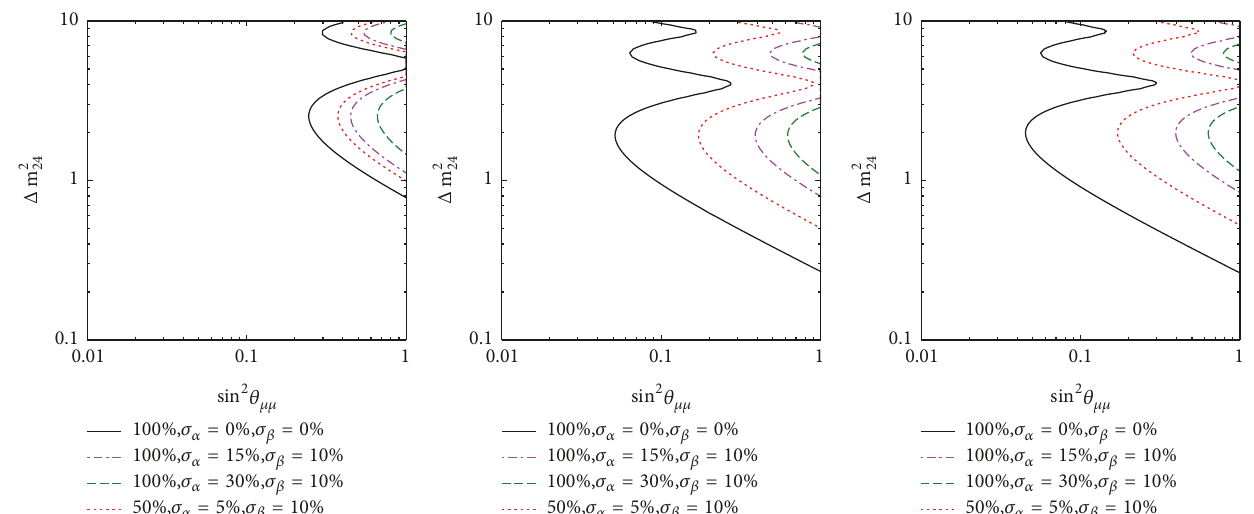
Figure 6: Expected sensitivity for a muon neutrino oscillation into a sterile neutrino state, for the different detectors under consideration: Germanium (left), Argon (middle), and NaI (right), respectively. Again, the different curves are for the ideal case of 𝜎 𝛼 = 0 % with 100 % efficiency and a background error of 𝜎 𝛽 = 0 % (solid), for 𝜎 𝛼 = 5 % with 50 % efficiency and a background error of 𝜎 𝛽 = 10 % (dotted), for 𝜎 = 15 % with 100 % efficiency and a background error of 𝜎 = 10 % (dashed-dotted), and 𝜎 = 30 % with 100 % efficiency and a background 𝛼 𝛽 𝛼 error of 𝜎 𝛽 = 10 % (dashed); see text for details. The horizontal line indicates the 90 % CL.